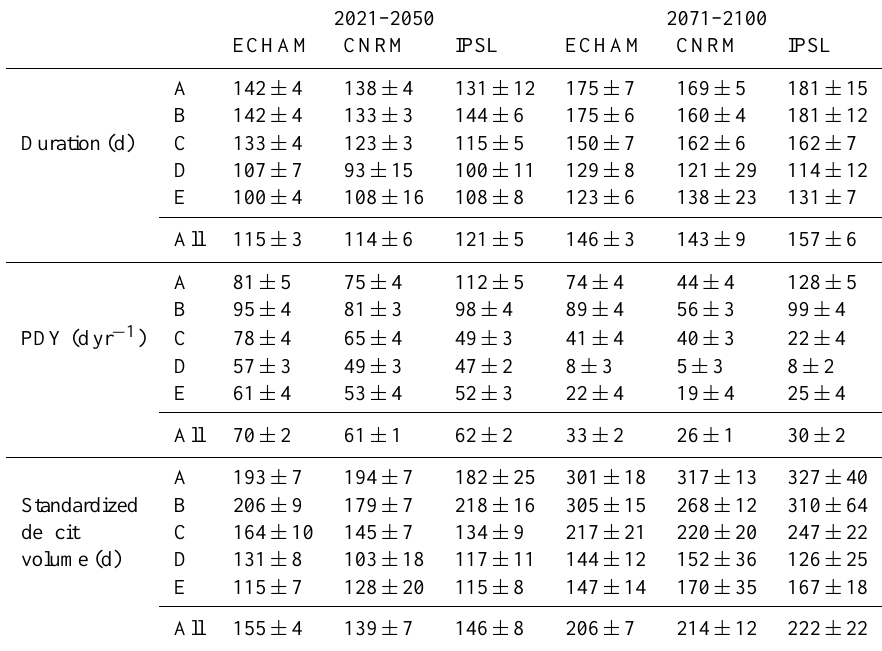
Table 4. Changes in median of drought characteristics (% relative to control period, 1971–2000, including standard deviation, derived from a two-sided t -test) for climate types: Equatorial (A), Arid (B), Warm temperate (C), Snow (D) and Polar climates